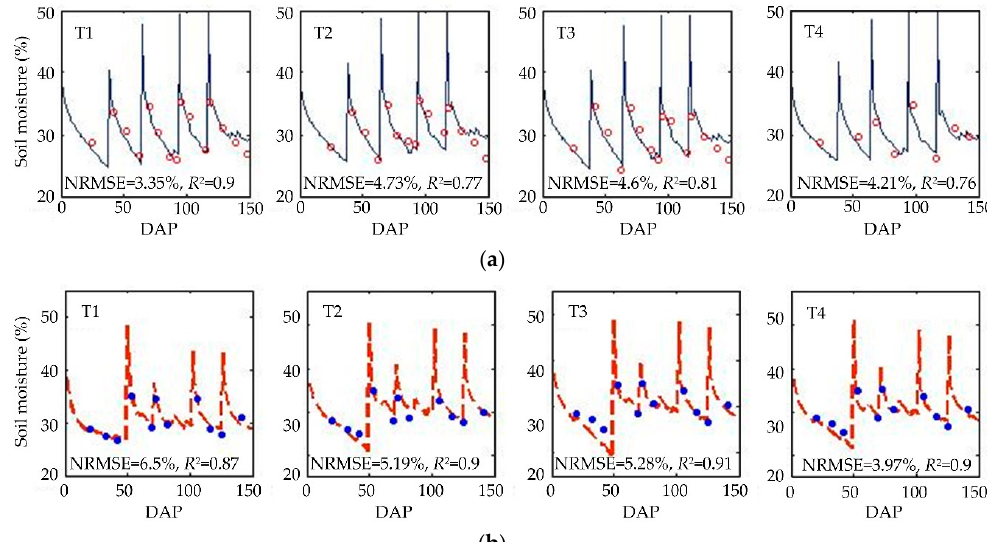
Figure 5. Results of soil water balance simulation model calibration ( a ) and validation ( b ). Note that DAP means “days after planting”.